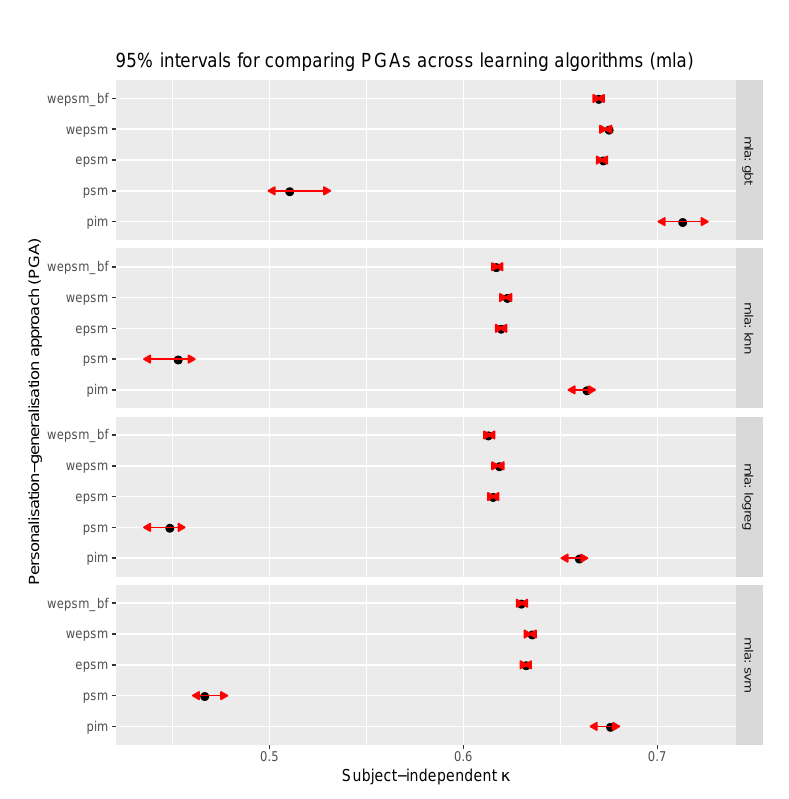
Figure 5. Estimated marginal means for comparing the subject-independent performance of personalisation–generalisation approaches across learning